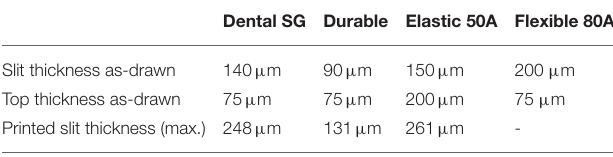
TABLE 1 | Dimensions of the valves with the smallest top-and slit